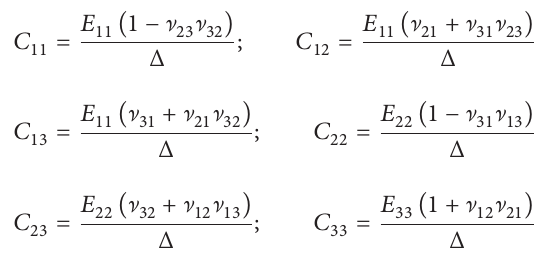
Figure 12: Variation of the second mode natural frequency with the radius of the plate with different boundary conditions ( 𝑏 = 0.05 m and ℎ 𝑐 = 0.0005